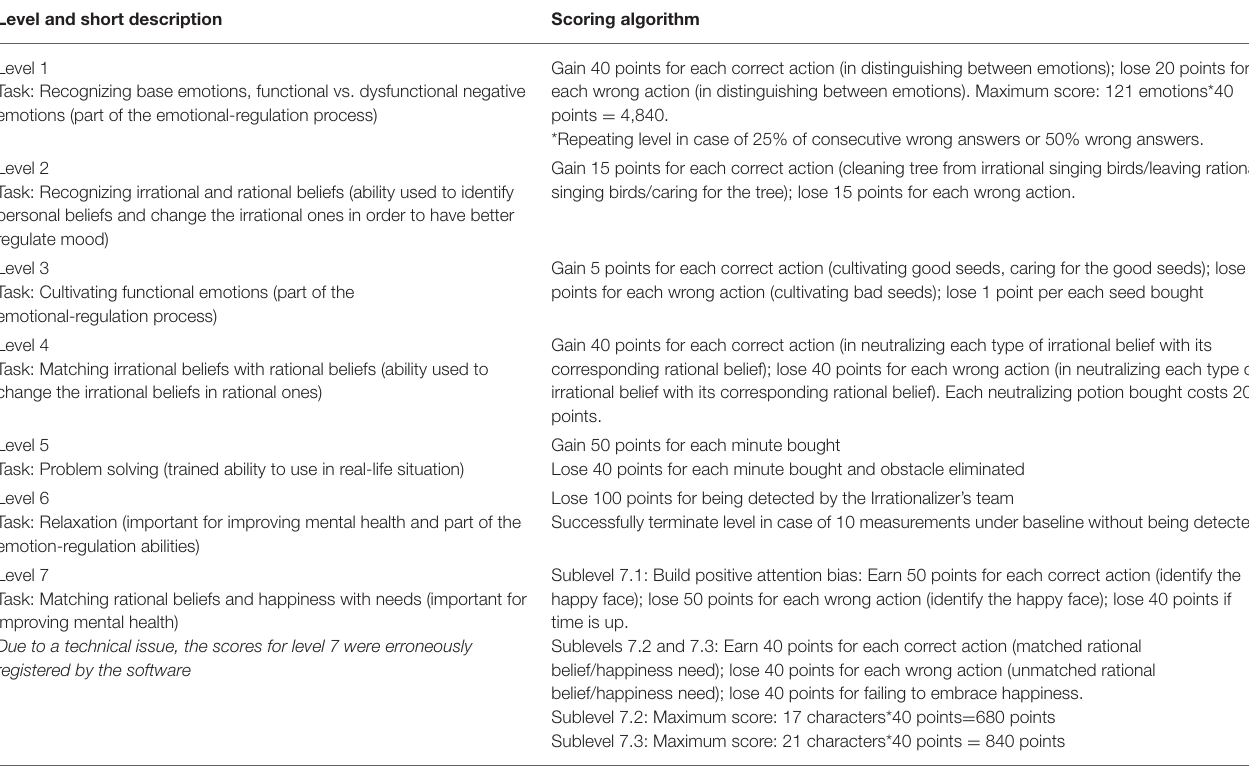
TABLE 1 | Short description of the RET hink levels and scoring algorithm. Level and short description Scoring